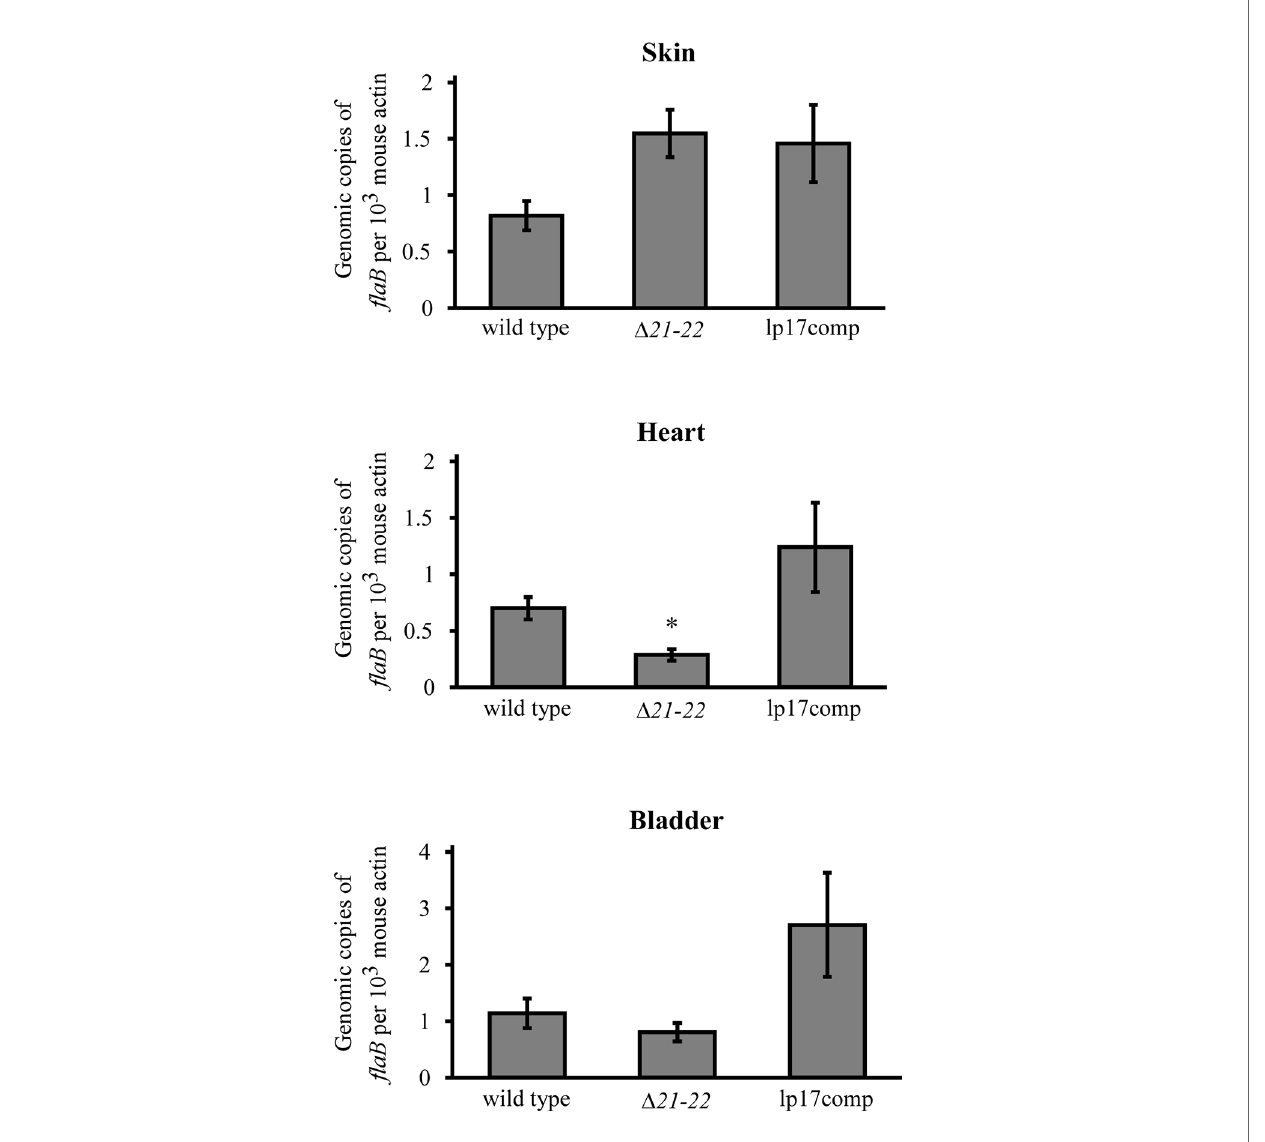
FIGURE 5 | bbd21-bbd22 is required for ef fi cient colonization of the heart in immunocompetent mice. Three C3H mice per group were infected in the subcutis over the dorsum with 1x10 4 spirochetes. Skin at the inoculation site, heart, and urinary bladder were collected at 21 days post-infection. Spirochete burden was assessed by qPCR analysis of genomic DNA isolated from these tissues. Gray bars represent the mean values of ( B ) burgdorferi fl aB copies normalized to 10 3 mouse actin copies, and error bars represent standard error mean. *p<0.05 (Student ’ s t